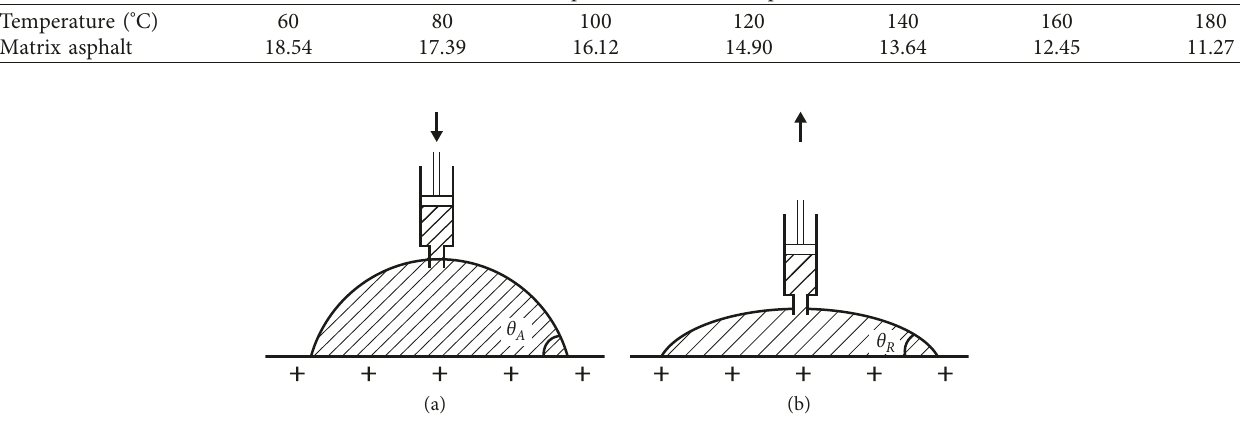
Table 2: Surface tension of asphalt at different temperatures (mN/m).